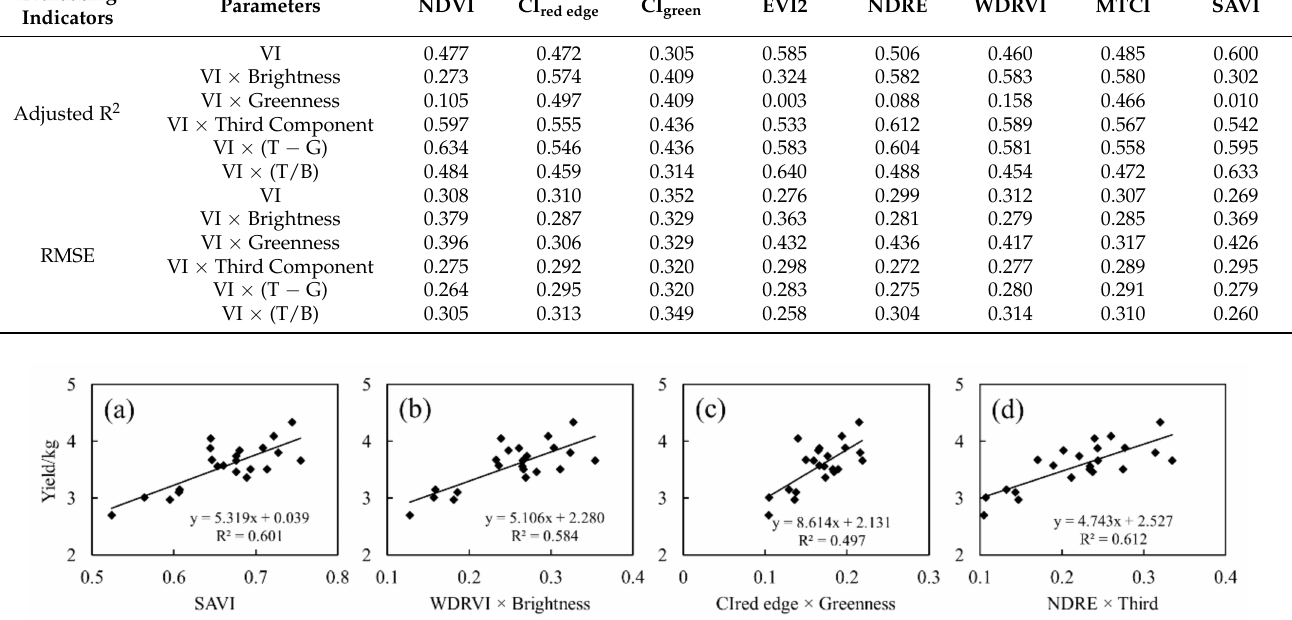
Figure 9. Well-performing yield-estimation models incorporating TCT parameters and VIs at the heading